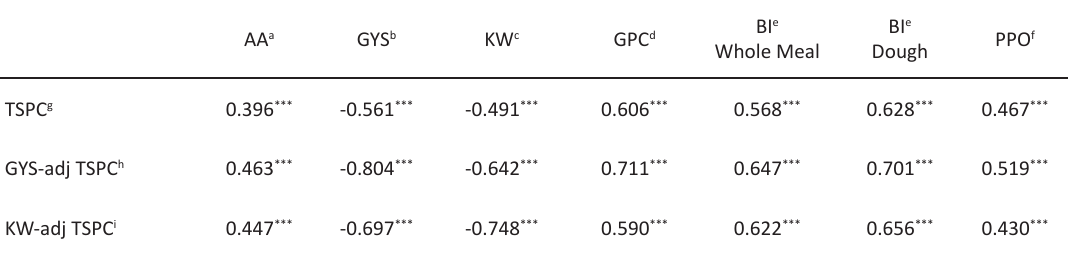
Table 4. Correlation coefficients ( r ) among observed and adjusted values of soluble phenolic compounds and some yield and quality characteristics in a collection of tetraploid wheat grown at Valenzano (Bari, Italy) in 2010. AA a GYS b